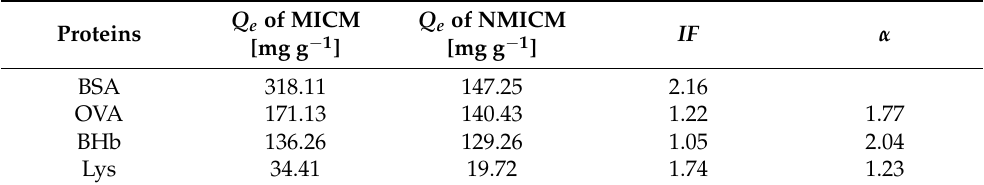
Table 3. The recognition selectivity of MICM and NMICM toward different proteins. Proteins